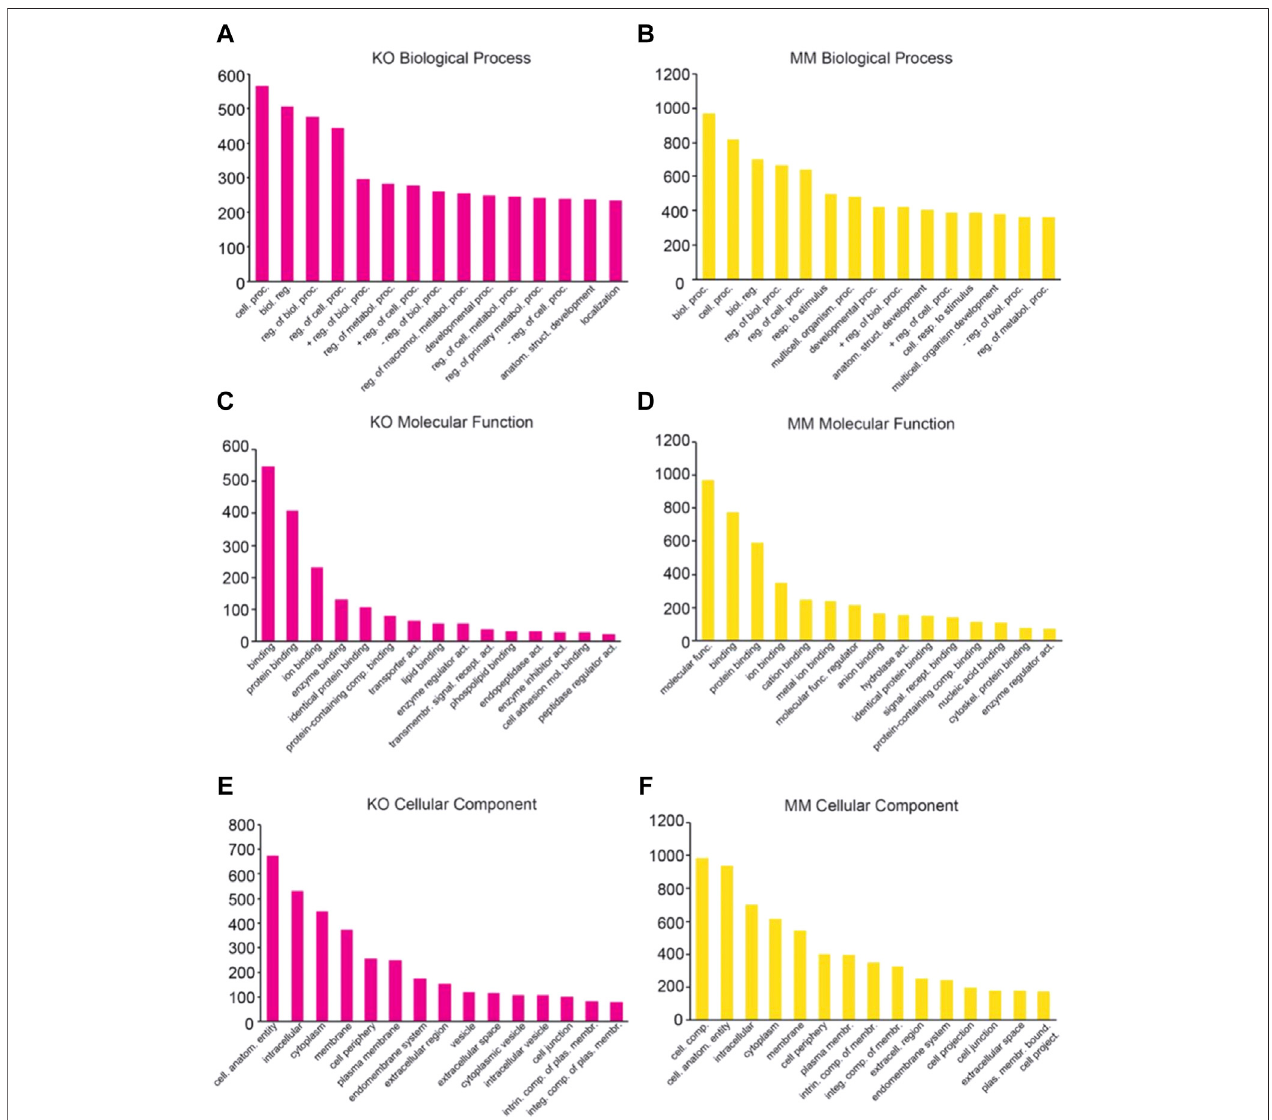
FIGURE 4 | Classi fi cation of differentially expressed genes based on Gene Ontology. The differentially expressed genes in Dot1L -KO and Dot1L -MM ESREs were subjectedtoPantherClassi fi cationAnalysis(http://pantherdb.org).Differentiallyexpressedgeneswereclassi fi ed.basedonBiologicalProcess (A,B) ,MolecularFunction (C,D) and Cellular Components (E,F)